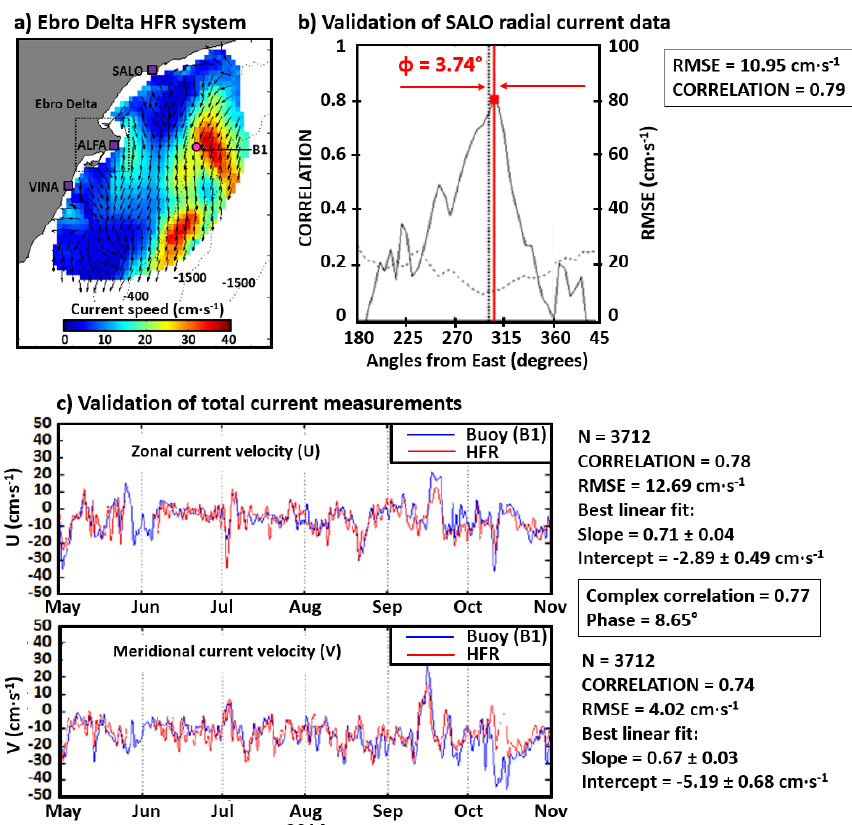
Figure 4. Validation of hourly surface currents provided by the HFR deployed in Ebro Delta (NW Mediterranean Sea), shown in Fig. 1, against a buoy for May–October 2014 (Lorente et al., 2015). (a) Example of an hourly map of surface current circulation. The pink dot and purple squares represent the buoy and HFR site locations, respectively. (b) Validation of radial currents. Correlation (solid line) and RMSE (dashed line) between radial currents estimated by the buoy and those measured by the SALO HFR site. The vertical dotted line represents the angular position of the moored buoy. The vertical red solid line denotes the angular position of maximum correlation, which is gathered with the associated RMSE and bearing offset (in red) values. (c) Low-pass-filtered time series of zonal and meridional currents measured by the buoy (blue line) and HFR at the closest grid point (red